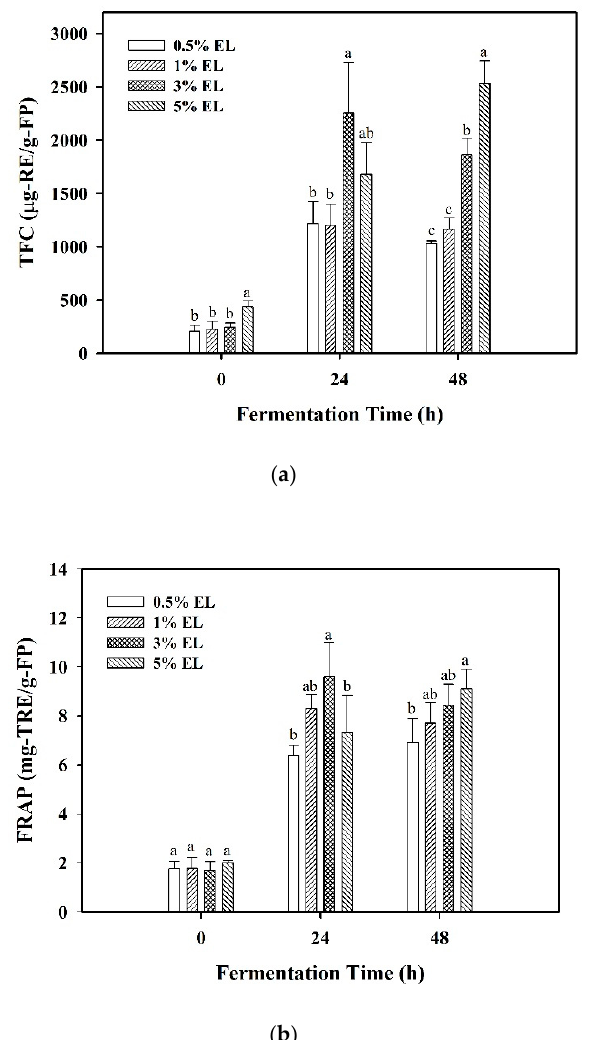
Figure 2. Comparison of fermented products with various %EL in MRS by L. plantarum : ( a ) total flavonoid content (TFC) vs. fermentation time; ( b ) ferric reducing antioxidant power (FRAP) vs. fermentation time. The data were expressed as mean ± standard deviations ( n = 3). Different letters at the same time show significant differences among the different %EL ( p < 0.05) by Duncan’s multiple range